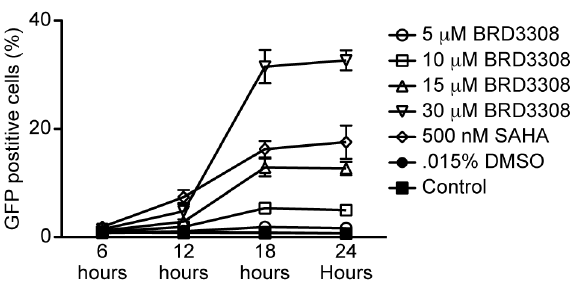
Figure 6. An HDAC3 selective inhibitor induces HIV-1 expres- sion from 2D10 cells. 2D10 cells were treated with BRD3308 at the indicated concentration for 6 hours, 12 hours, 18 hours, or 24 hours and collected for analysis at 24 hours. The percent of 2D10 cells expressing GFP was measured using flow cytometry. HIV-1 expression was observed with 10 m M of BRD3308 and higher after 12 hours of